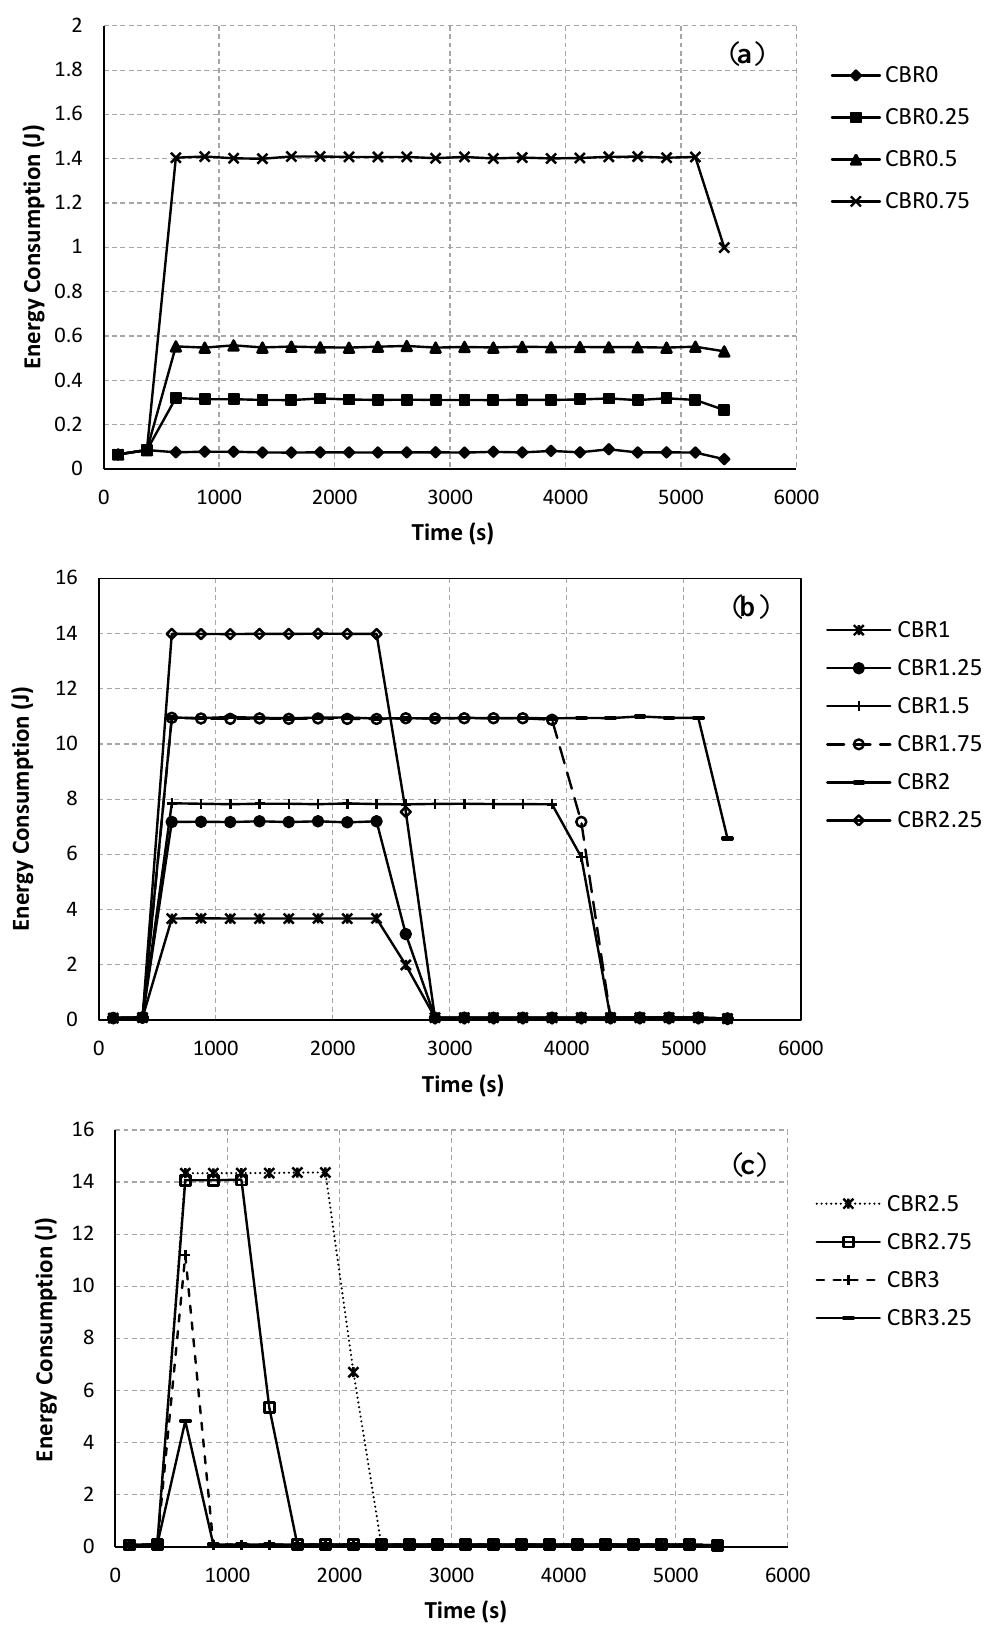
Figure 7. Energy consumption at each window interval vs . CBR rate. ( a ) Vary the CBR rates from 0 to 0.75 Mbps. ( b ) Vary the CBR rates from 1.00 to 2.25 Mbps. ( c ) Vary the CBR rates from 2.50 to 3.25